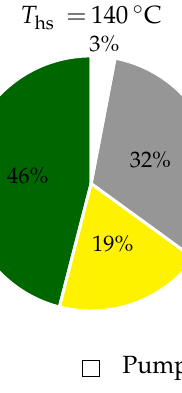
Figure 6. Exergy destruction contributions of the various components of the ORC